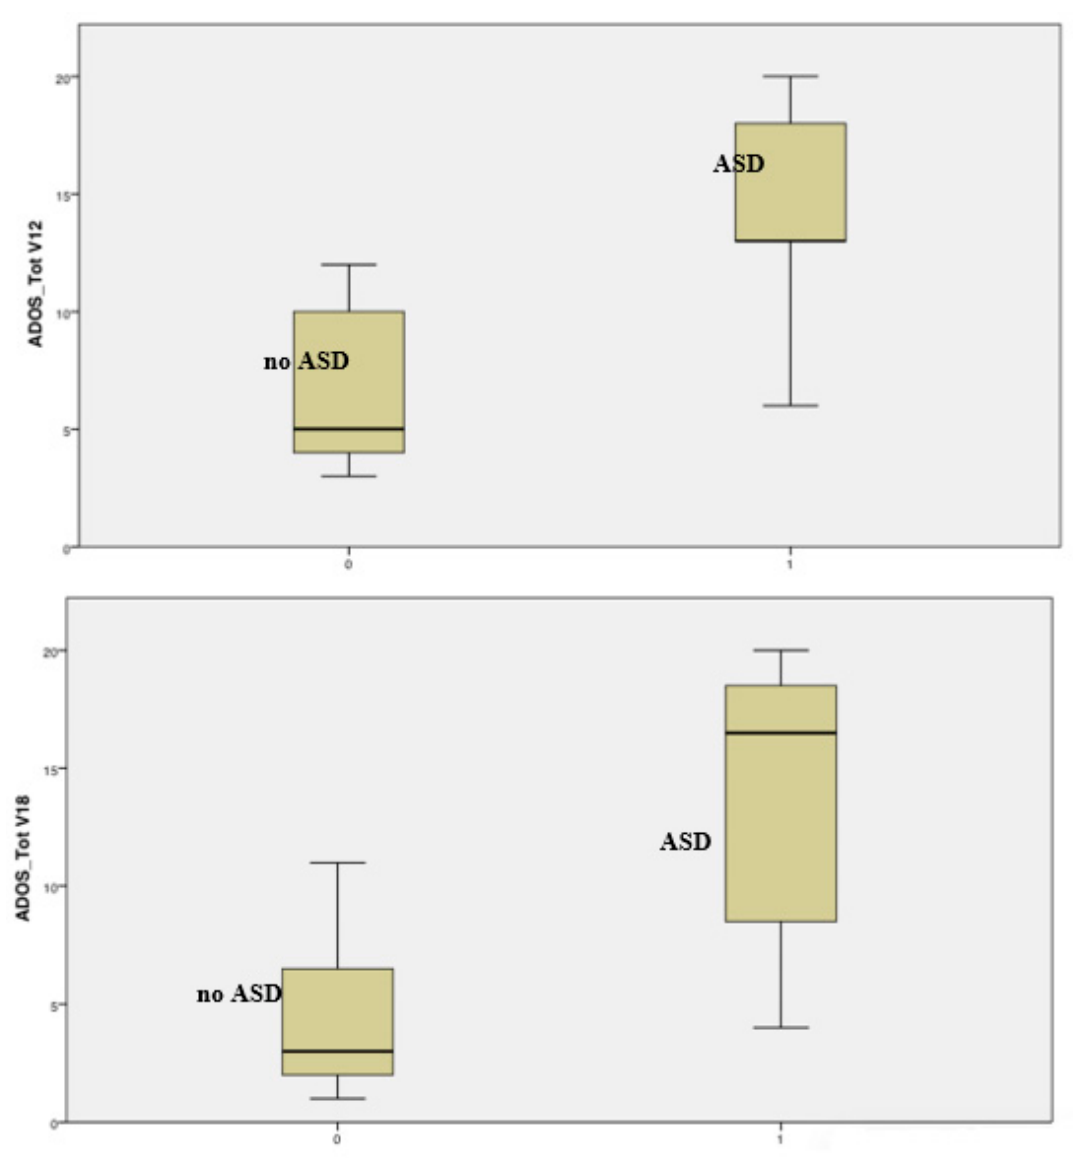
Figure 3. Distribution of ADOS total scores at 12 and 18 months of age in children with (group 1) and without (group 0) a diagnosis of ASD at 24 months. The chart shows a clear differentiation of distribution, already present at 12